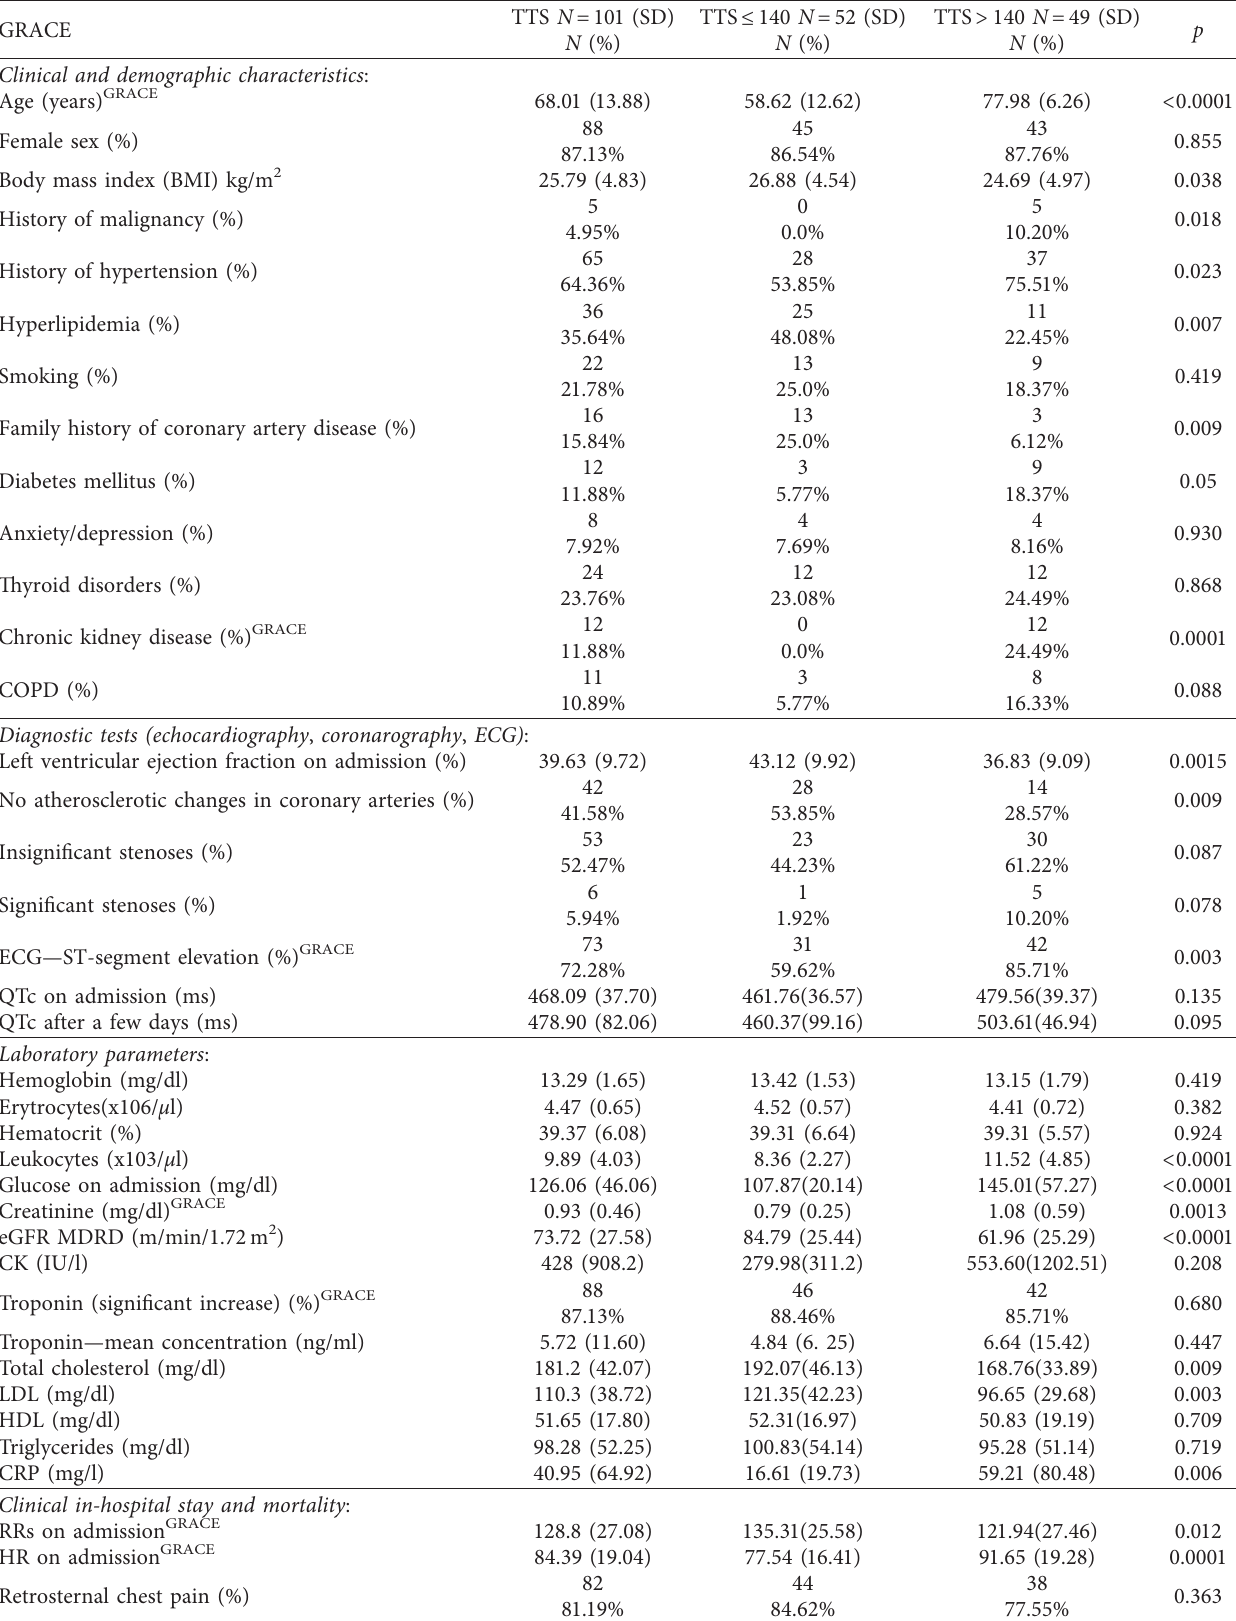
Table 1: Results—comparison of 2 groups of patients with Takotsubo ( N �